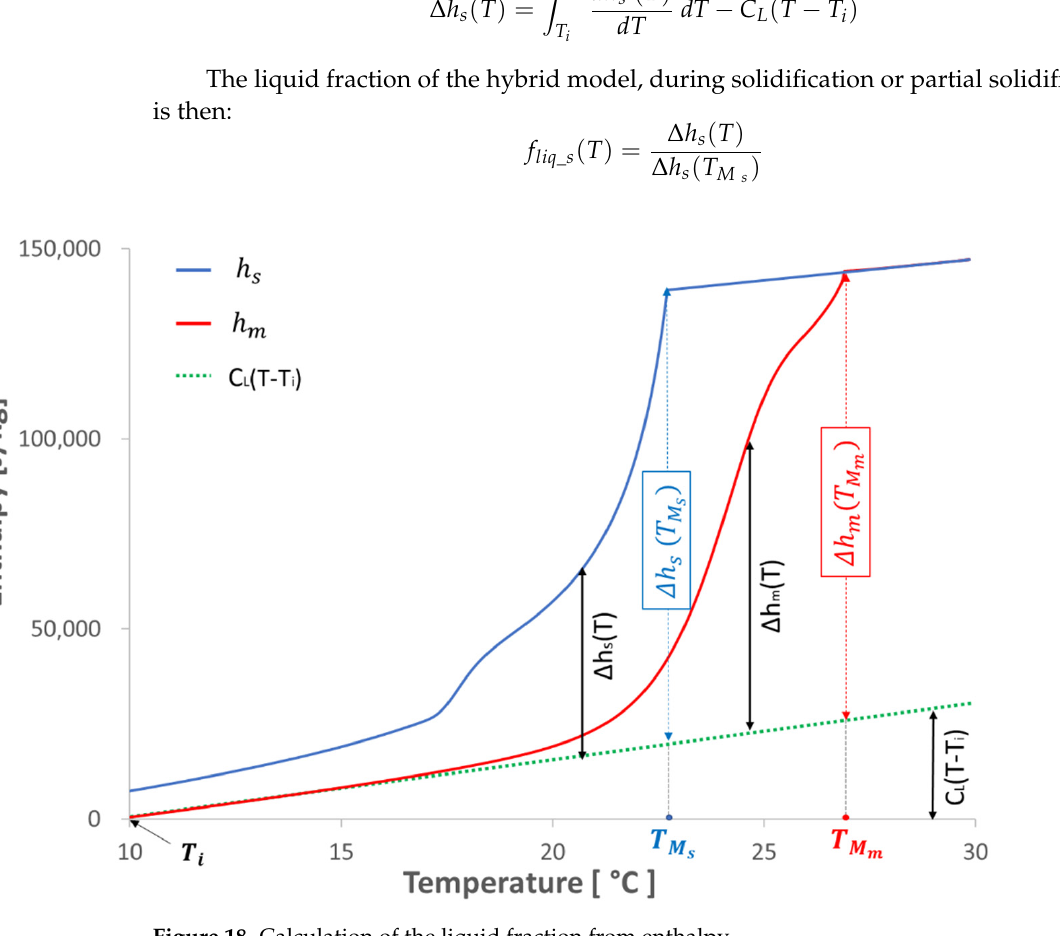
Figure 18. Calculation of the liquid fraction from enthalpy.